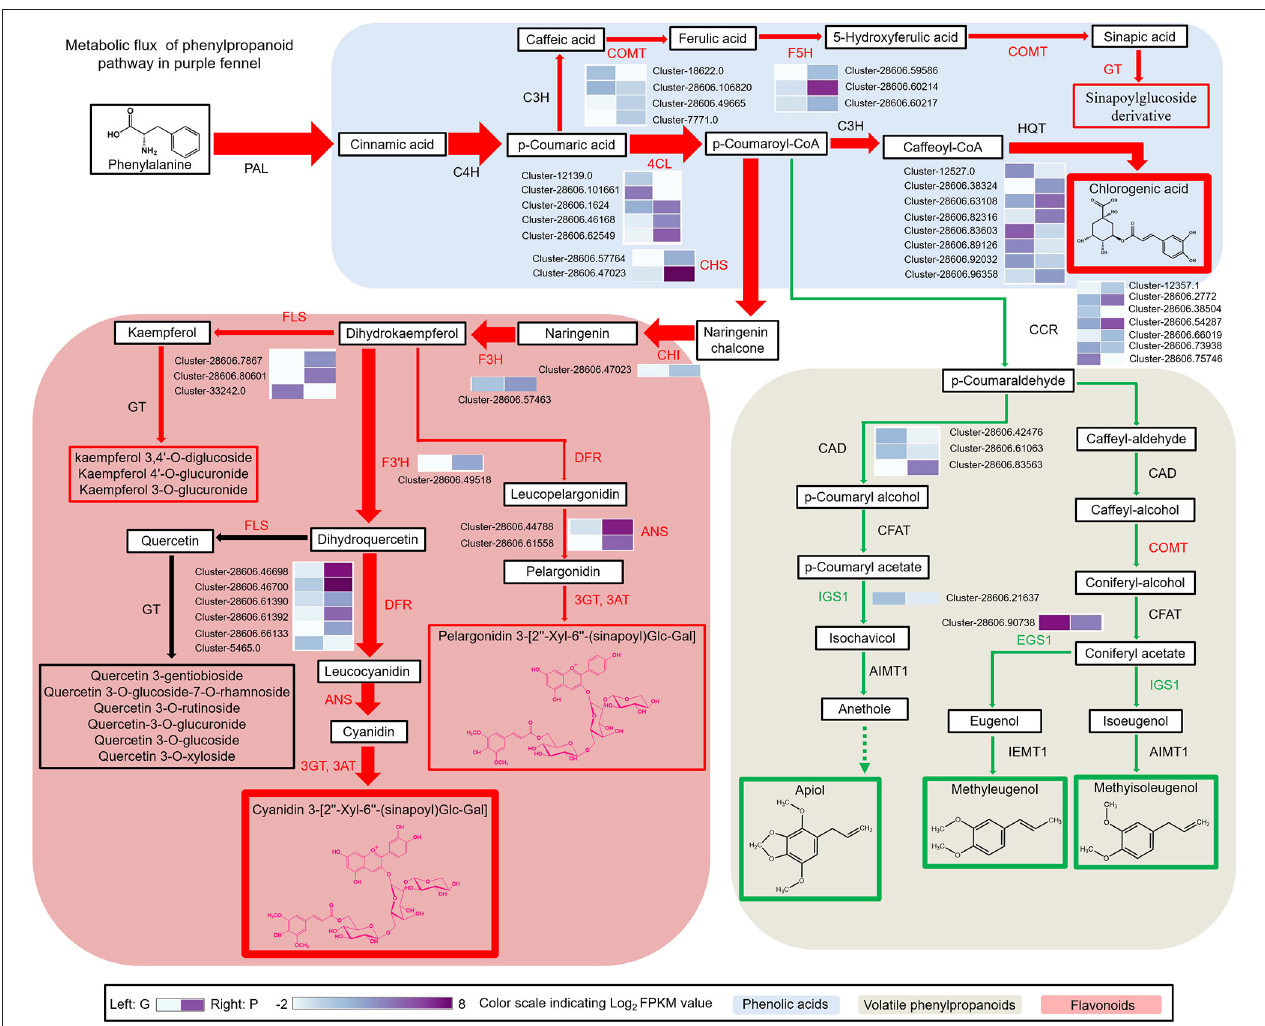
FIGURE 4 | The metabolic flux redirection in phenylpropanoid pathway accounts for the characteristic aroma and color formation of the purple fennel. The red arrow indicates reinforced metabolic flux, while the green arrow indicates reduced metabolic flux. The width of the arrow indicates the corresponding biomass. The enhanced and repressed metabolites were marked with red and green frame, respectively. Transcript profiling of phenylpropanoid pathway genes was presented as grids with different